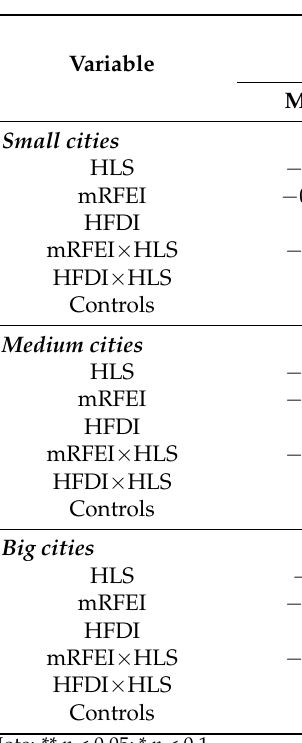
Figure 2. Food environment measures by city scale. Table 5. Heterogeneity effect of food environment by city